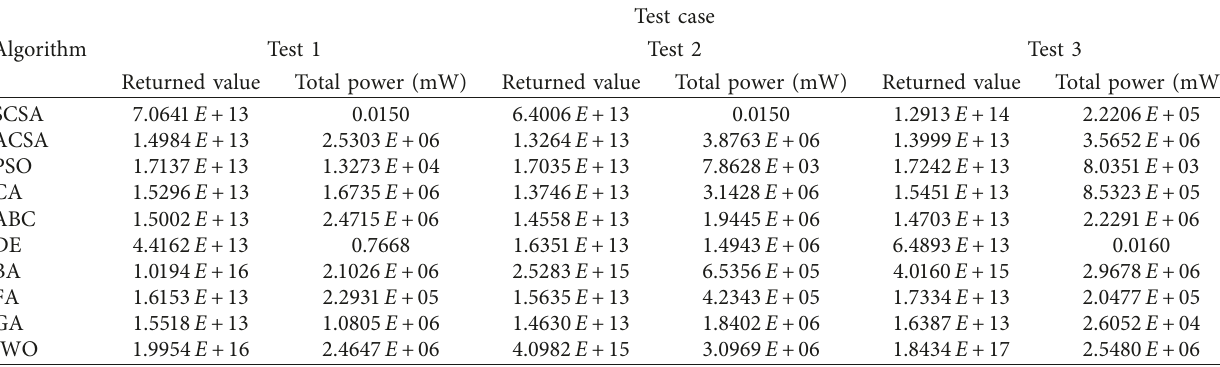
Table 19: Returned values and total power of ACSA and other standard optimization algorithms in scenario 3 in three more test cases. Algorithm